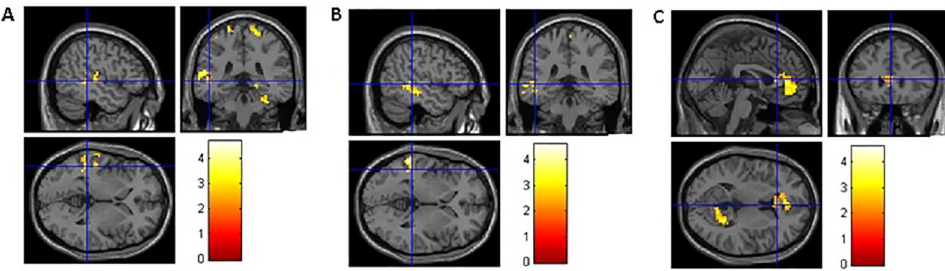
Fig 1. Brain areas showing stronger RSFC with seed ROIs related to WM. A and B show brain areas with strongerRSFC with left dlPFC and right dlPFC, and the coordinatesof the cross in A and B are the same, [–48, –36, 0]. C shows brain areas with stronger RSFC with left dlPFC, and the coordinates of the cross in C are [0, 27,